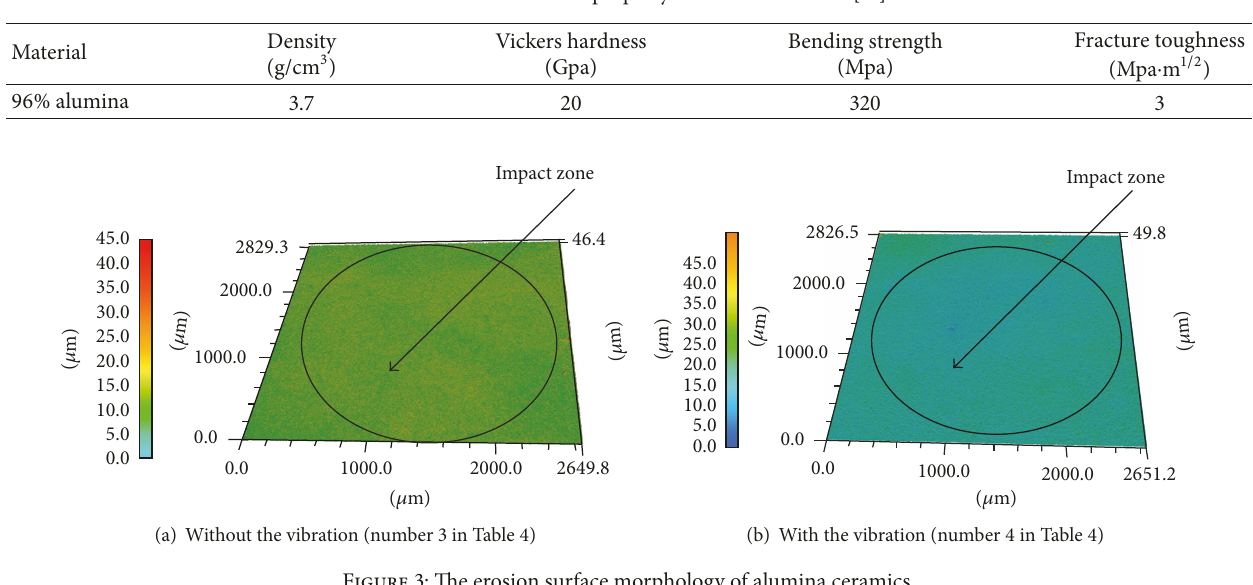
Figure 3: The erosion surface morphology of alumina ceramics.